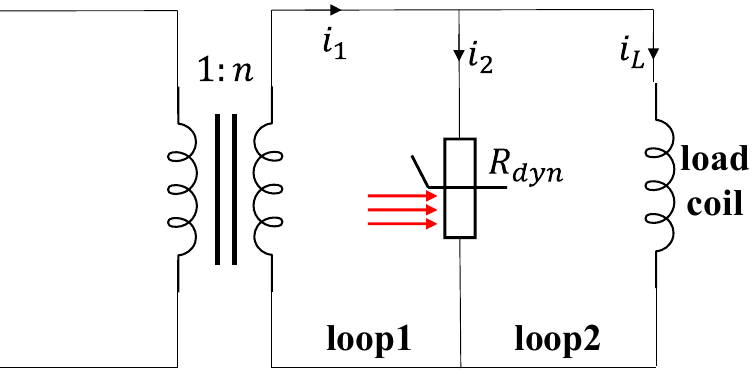
Figure 11. Circuit diagram for a transformer-rectifier HTS flux pump (red arrows denote the applied magnetic field).